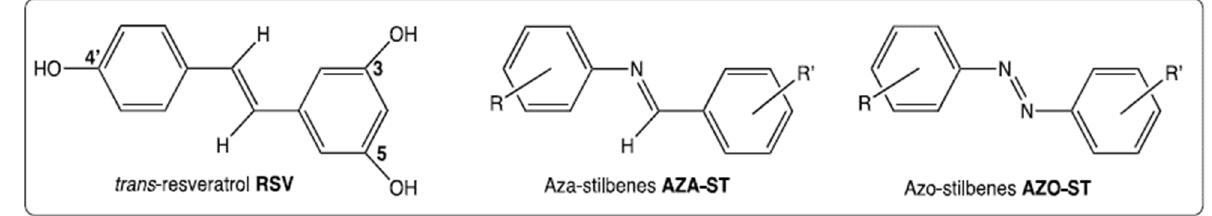
Figure 1. Structure of trans -resveratrol (RSV), aza-stilbenes (AZA-ST), and azo-stilbenes (AZO-ST) [15] .